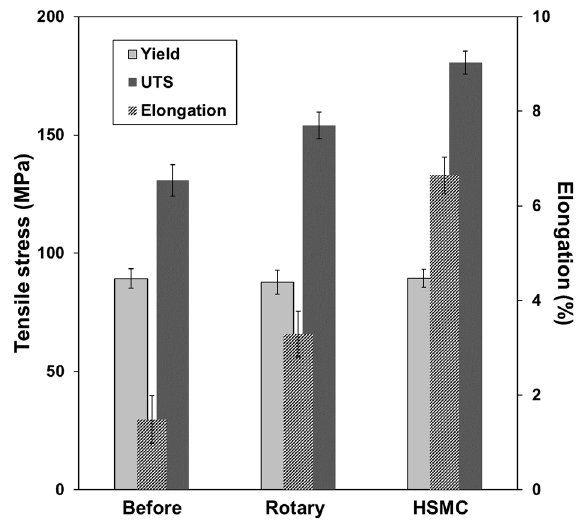
Figure 10. Mechanical properties of tensile bars cast before degassing and after processing by rotary degassing (5 L/min–350 rpm) and by HSMC degassing (0.1 L/min–3000 rpm). Average values from results in [24].